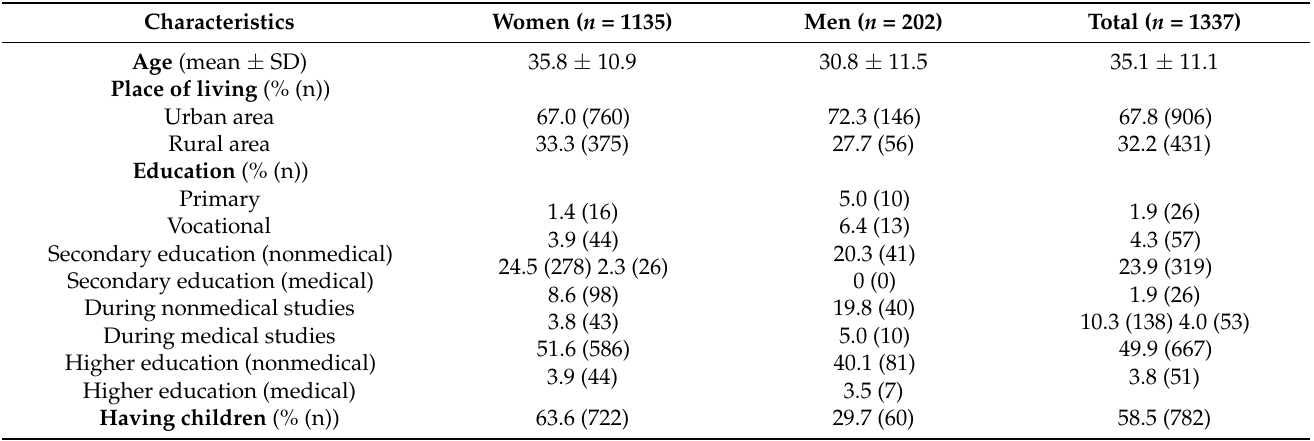
Table 1. The demographic breakdown of the studied group ( n = 1337).